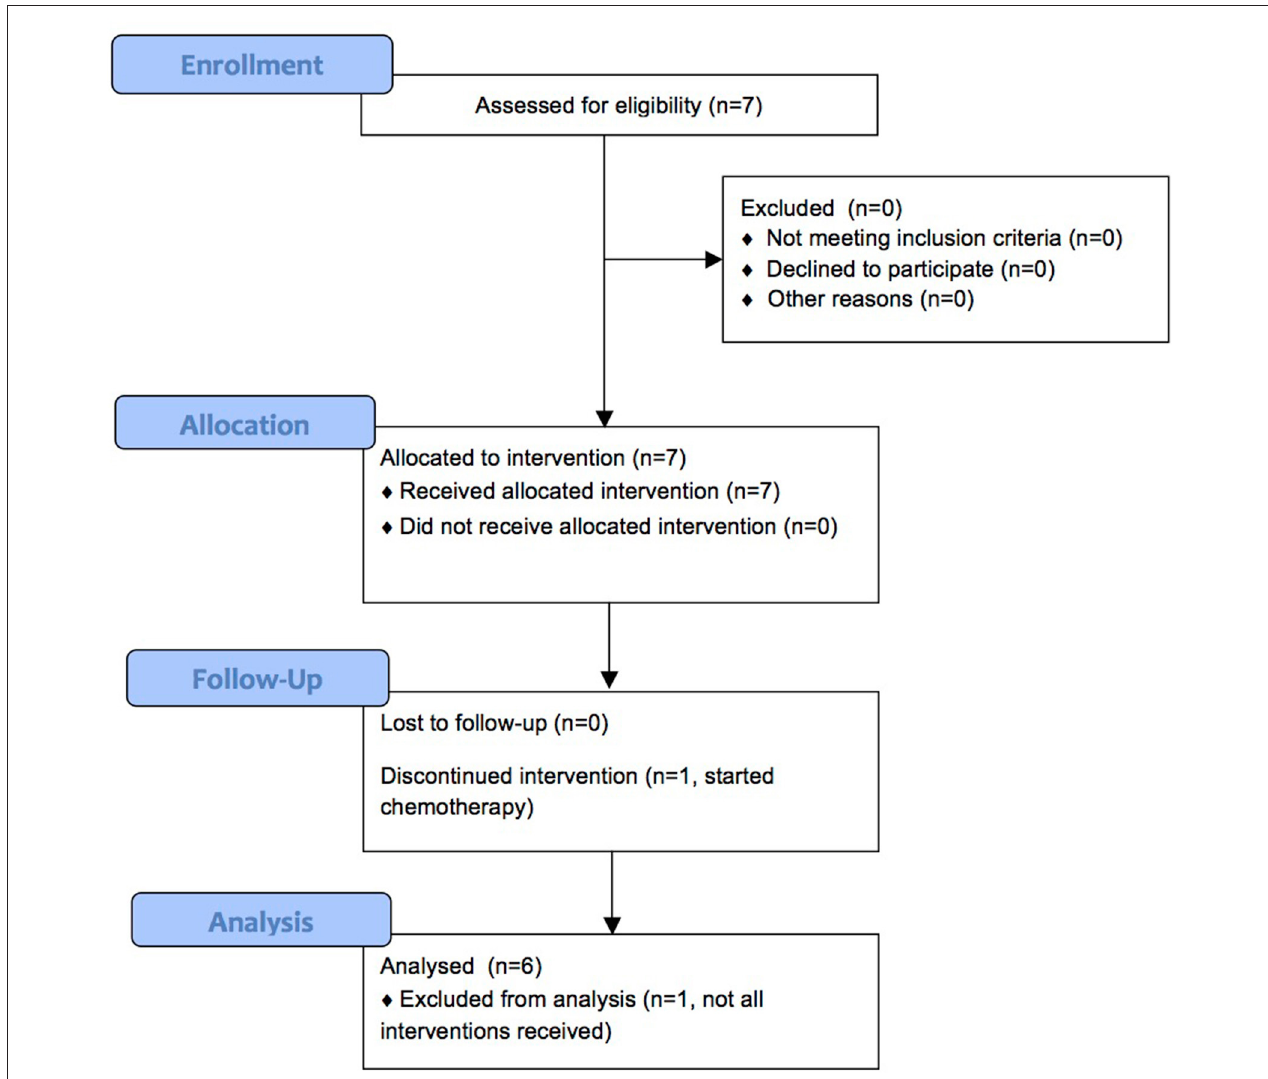
FIGURE 1 | CONSORT flow